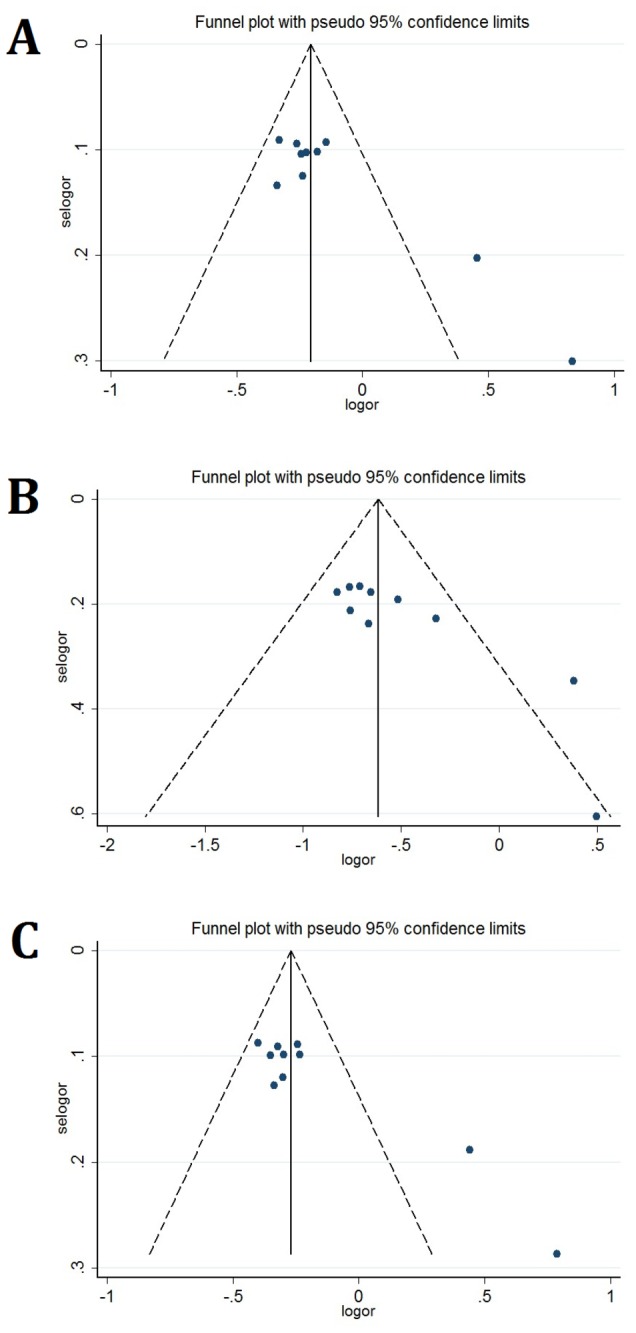
Funnel plots of the Egger’s test of IL-23R rs10889677 allele comparison for publication bias.Funnel plots for AC vs. AA comparison (A, CC vs. AA comparison (B), and AC + CC vs. AA comparison (C).